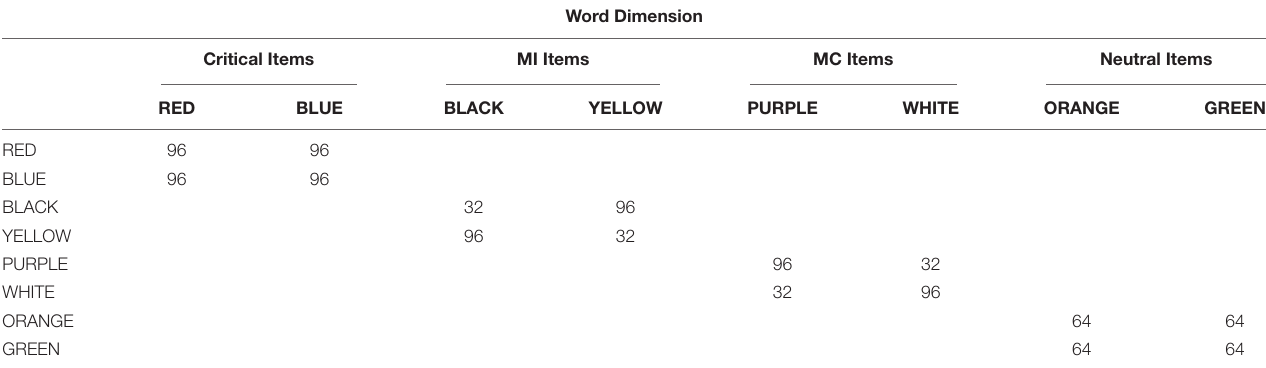
TABLE 1 | Stimuli frequencies in Experiments 1 and 2.